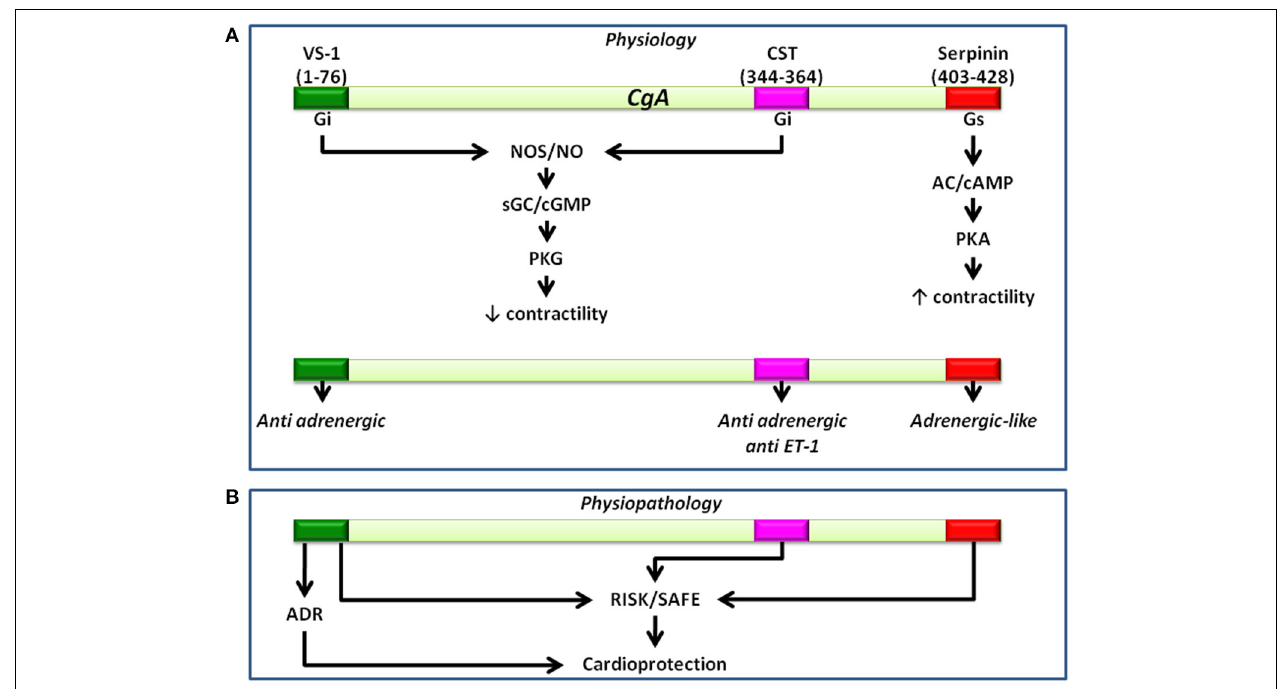
FIGURE 3 | Representative scheme showing the physiological (A) and the physiopathological (B) (i.e., cardioprotection) pathways activated by CgA-derived peptides. Cardioinhibitory effects induced by